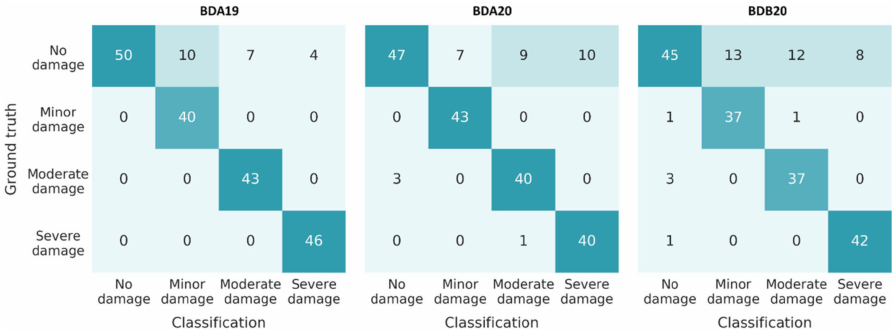
Figure 9. Confusion matrices of biotic damage (2019) ( left ), biotic damage (2020) ( middle ), and biotic damage (2020) excluding pixels of dead trees ( right ).